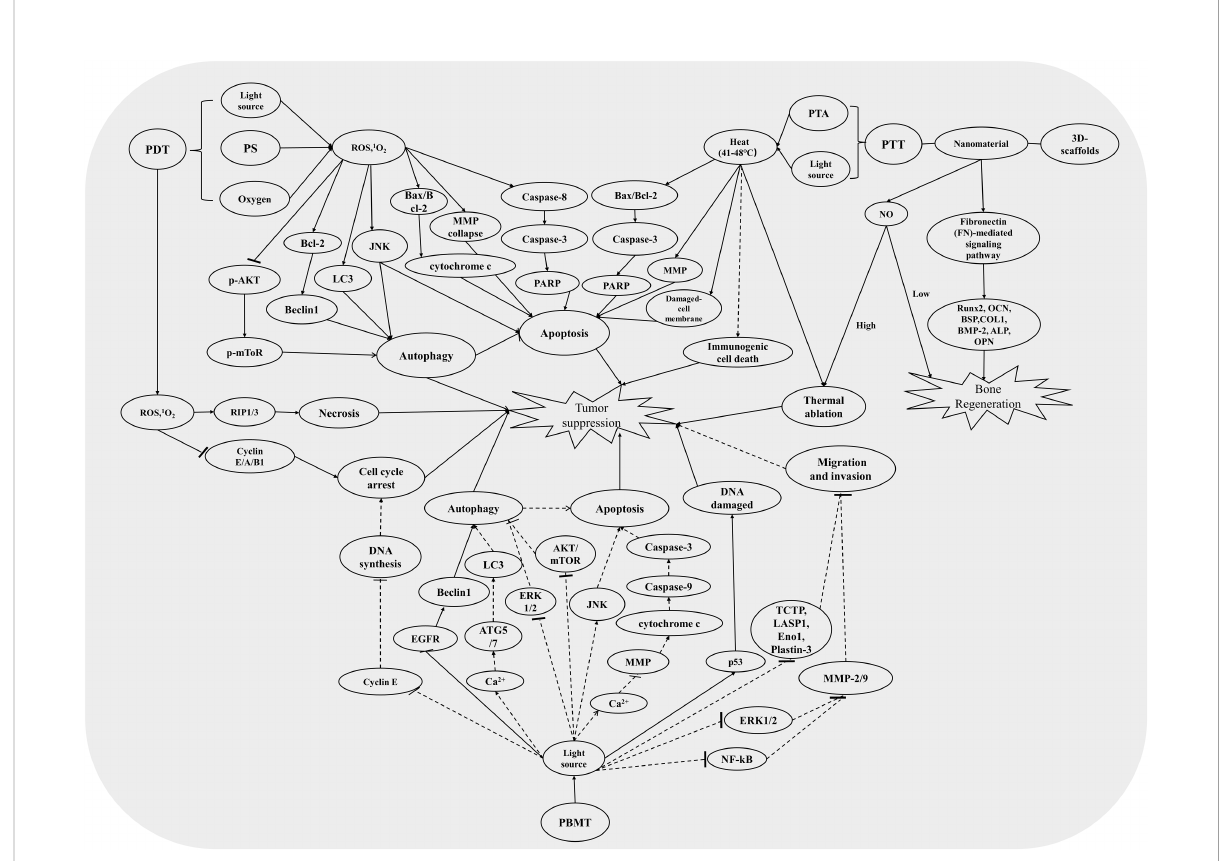
FIGURE 2 The relevant mechanism pathways involved in PDT, PTT, and PBMT induced an antitumor effect. The solid line represents the pathways that have been studied in the treatment of osteosarcoma, and the dotted line represents the pathways that have been studied in the treatment of other tumors but not in